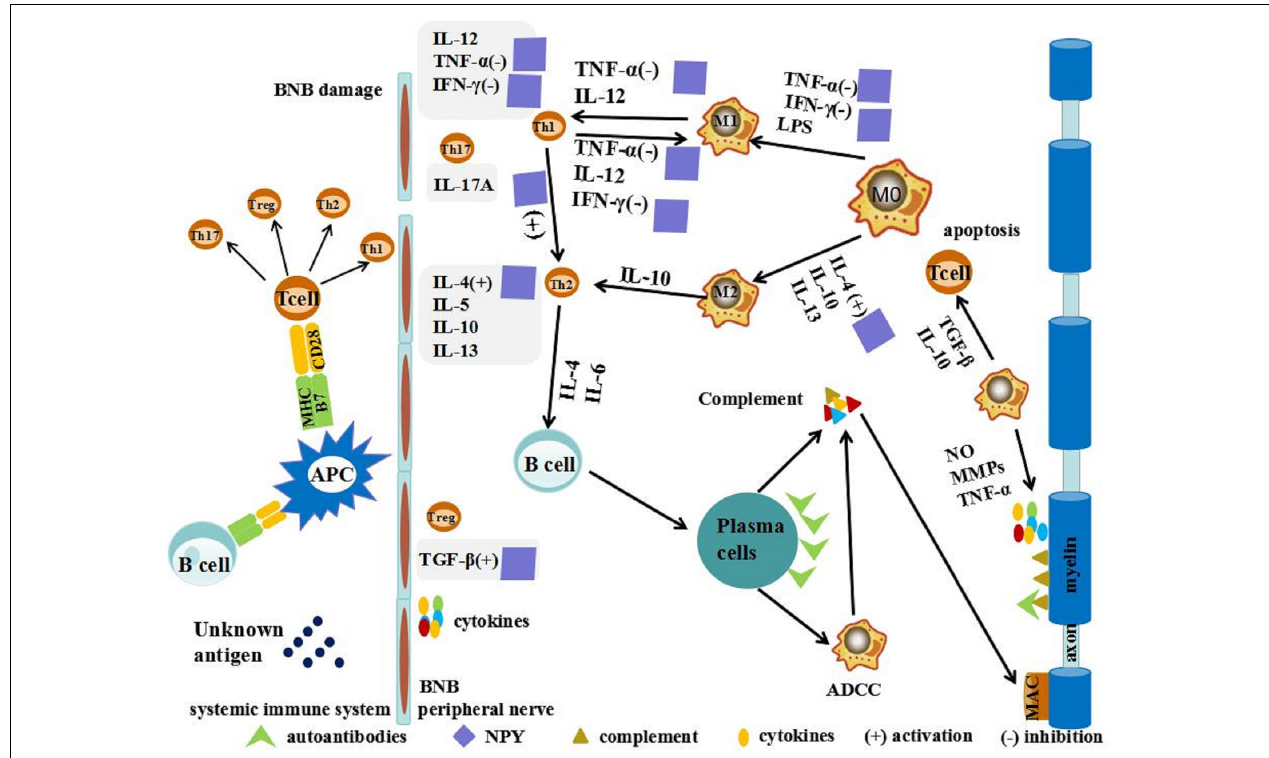
FIGURE 2 | Possible action of NPY in GBS/EAN. T cells are activated by unknown antigens on antigen-presenting cells (APCs) through a combination of major histocompatibility complex (MHC), T cell receptor (TCR), and co-stimulatory signals in the systemic immune system. These activated neurogenic T cells differentiate into pro-inflammatory T helper cells (Th1, Th2, and Th17) and regulatory cell (Treg). Th1 secretes pro-inflammatory cytokines such as tumor necrosis factor (TNF)- α and interferon (IFN)- γ and interleukin (IL)-12 to activate macrophages (M (cid:56) ). M (cid:56) have been primarily divided into two distinct subsets: pro-inflammatory macrophages (M1) and anti-inflammatory macrophages (M2). M1 macrophages promote breakdown of the blood-nerve barrier (BNB) by releasing nitric oxide (NO), matrix metalloproteases (MMPs), and TNF- α . M2 macrophages promote remyelination and tissue repair by secreting anti-inflammatory cytokines such as IL-10 and tumor growth factor (TGF- β ) and promoting T-cell apoptosis. NPY shifts the Th1/Th2 balance toward the Th2 phenotype, activating secretion of IL-4 and TGF- β , and inhibiting secretion of IFN- γ and TNF- α .